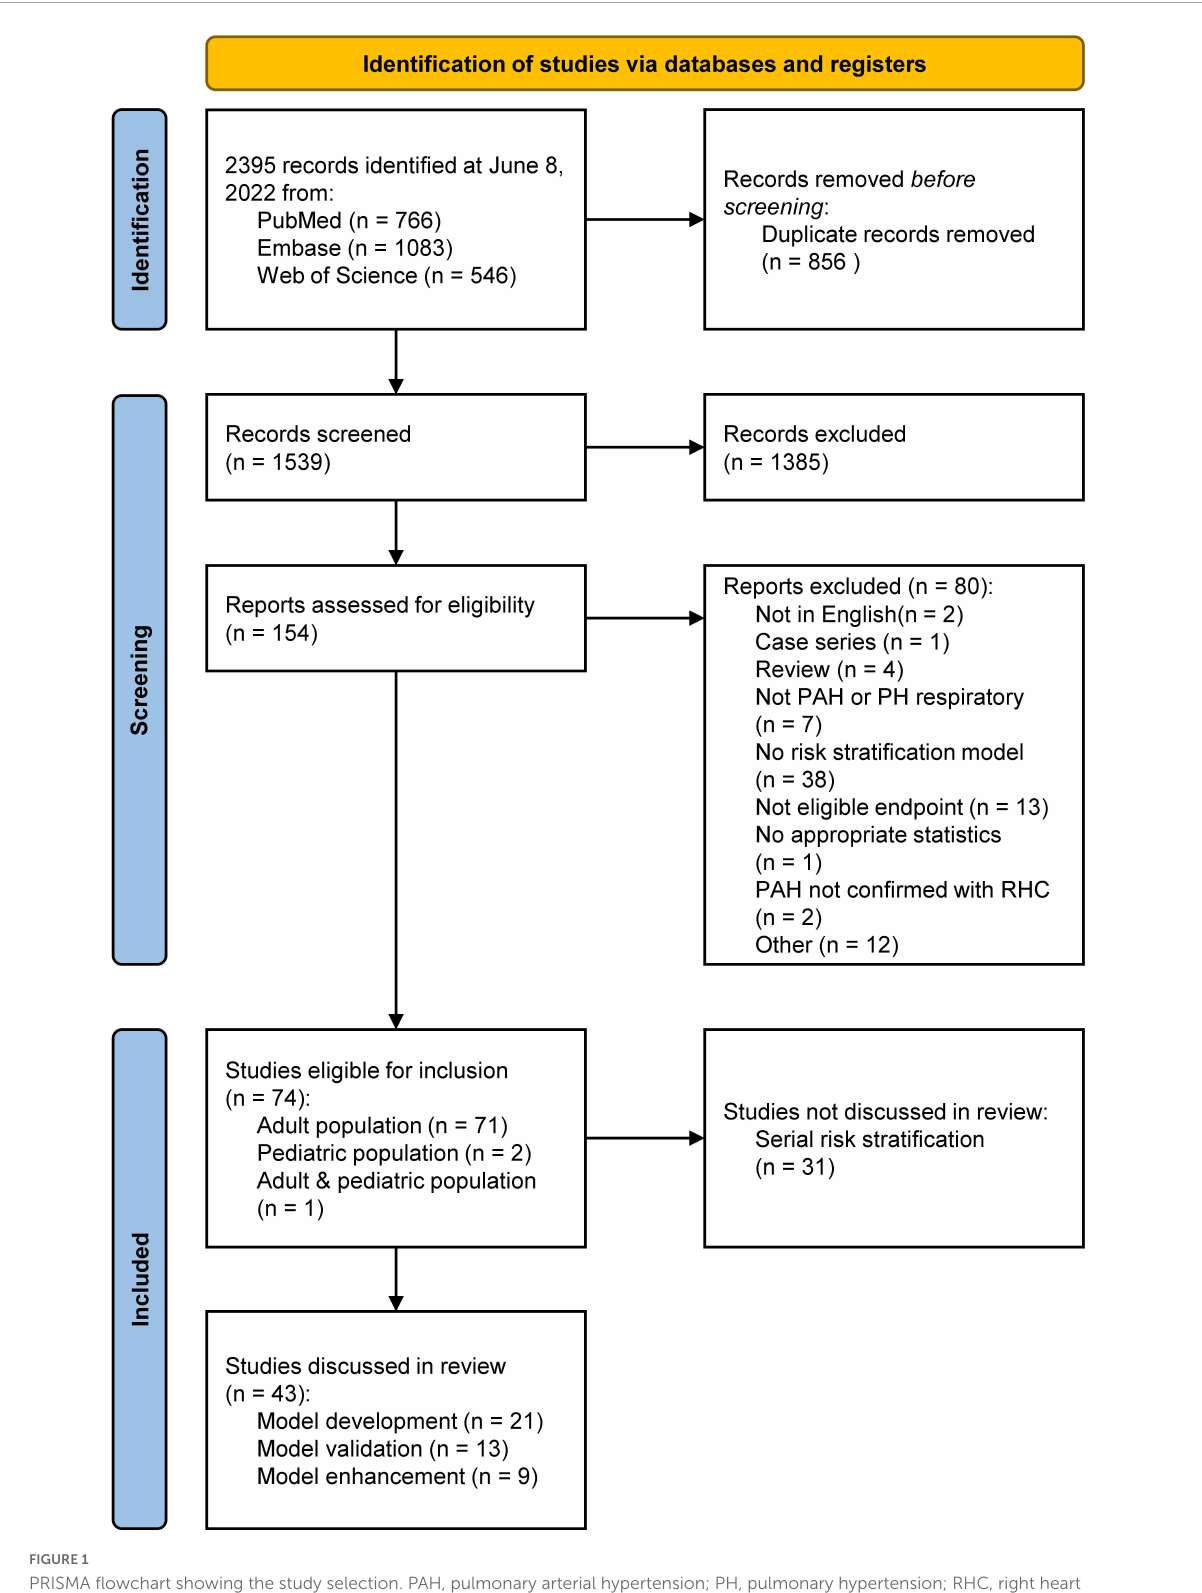
FIGURE1 PRISMA flowchart showing the study selection. PAH, pulmonary arterial hypertension; PH, pulmonary hypertension; RHC, right heart catheterization. Other reasons included editorials, retracted articles, and commentaries.